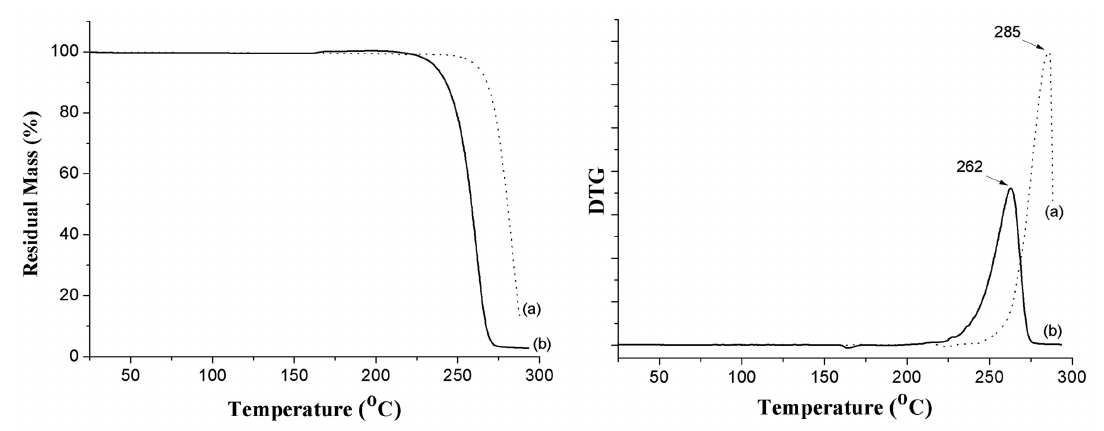
Figure 8. TG and DTG curves of: (a) PHB thermo-compression molded film and (b) PHB nanofibers mat.